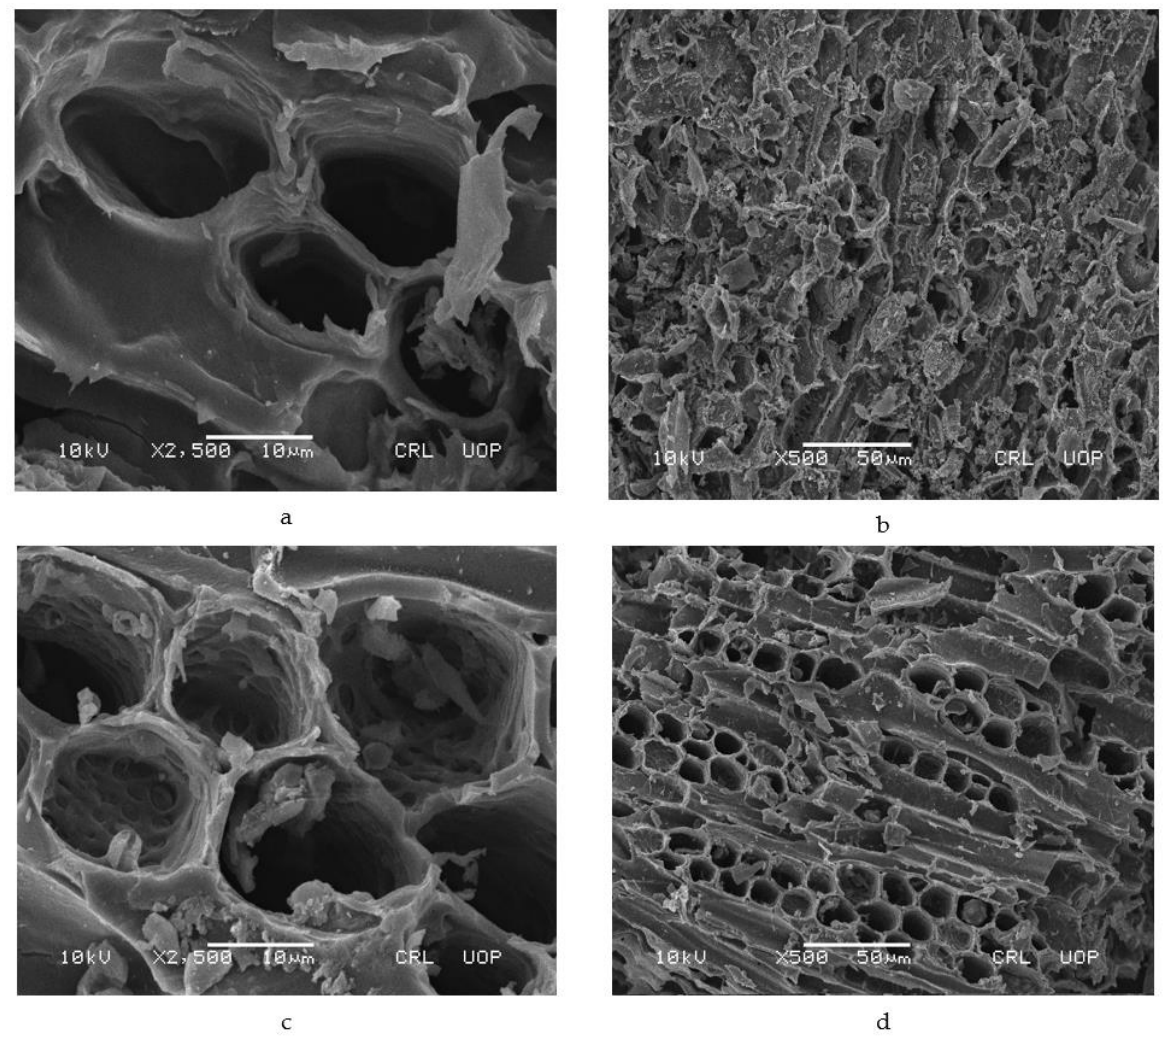
Figure 4. SEM images of ( a ) and ( b ) activated carbon, ( c ) and ( d ) magnetic activated carbon. Figure 5, represent FTIR Spectra of AC and MAC, respectively. A C ≡ C stretching could be detected from a peak present in the range of 2250–2300 cm − 1 , whereas the presence of tertiary amine is indicated by a peak in the range 3200–3400 cm − 1 which is considered to be responsible for the binding to AZM to adsorbate surface [23,24]. A peak in the range of 1700 – 1800 cm − 1 confirmed the presence of anhydride and aldehydes whereas the peak at 700 cm − 1 established the presence of iron oxide in MAC [25 – 27]. There is a notice- able difference in the positions of peaks between the spectra of AC and MAC after AZM adsorption, as evident from Figure 5.